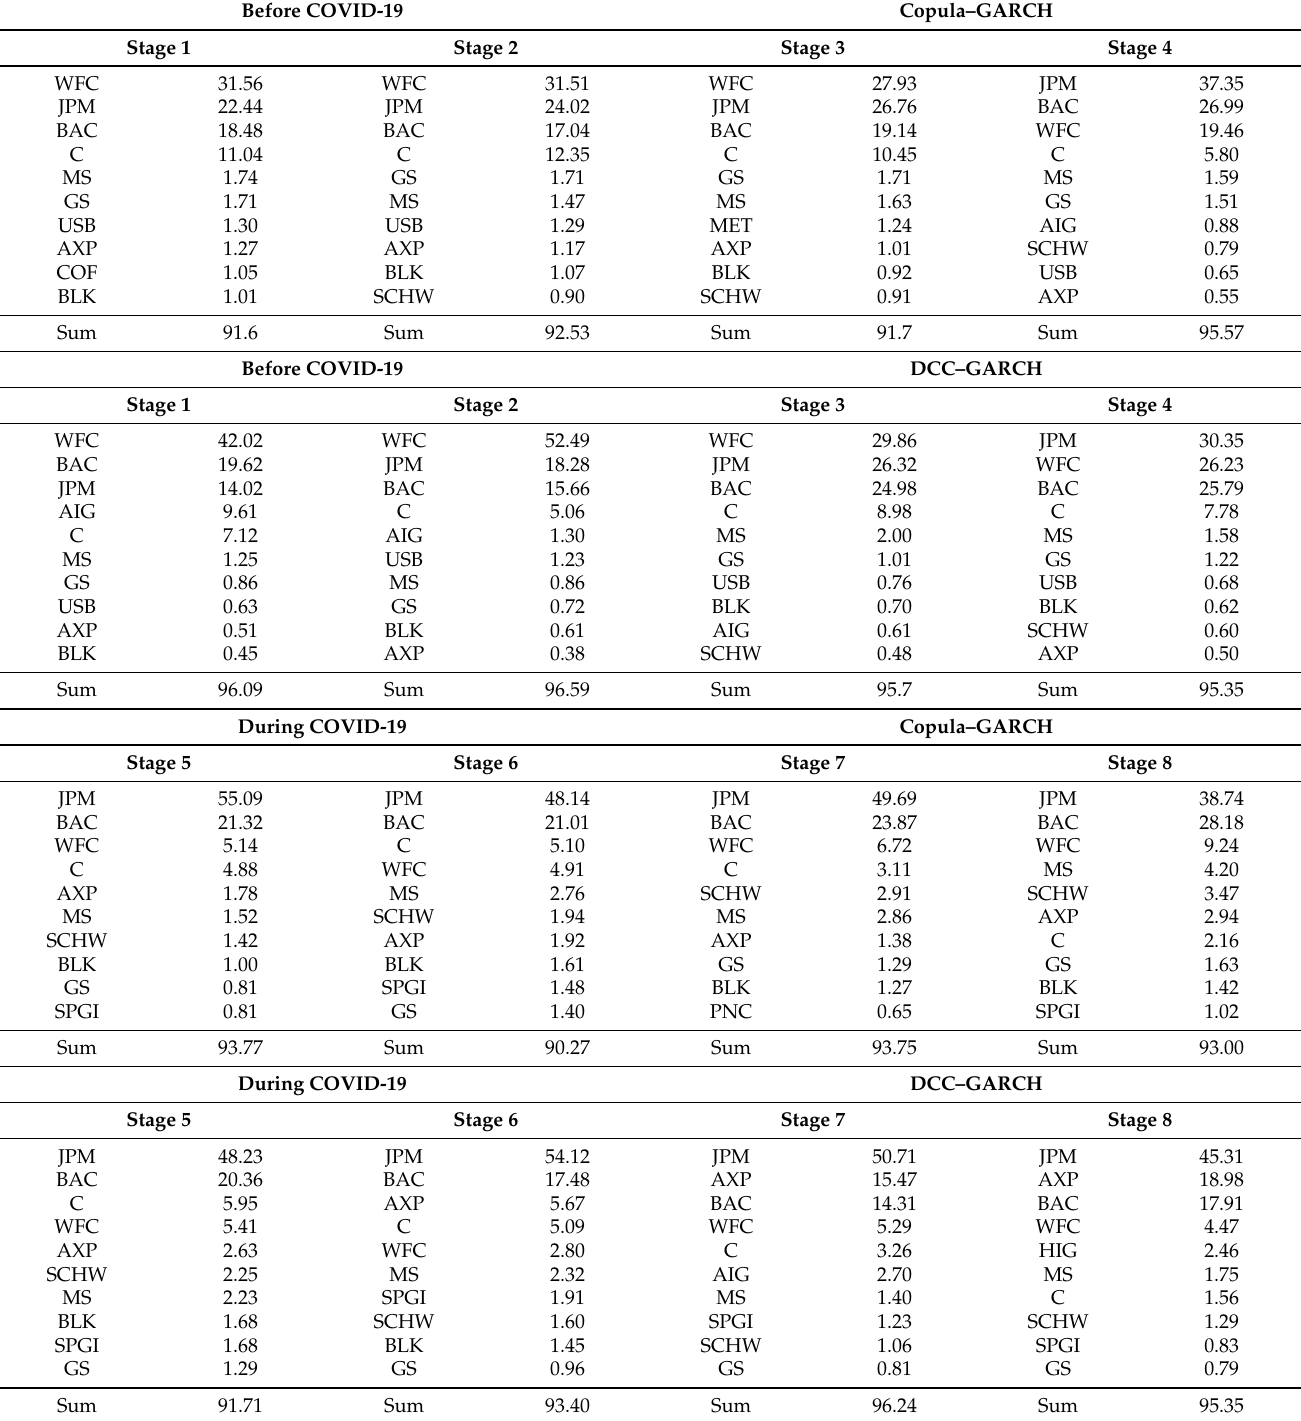
Table 6. Top 10 US financial firms ranks by CES% before and during